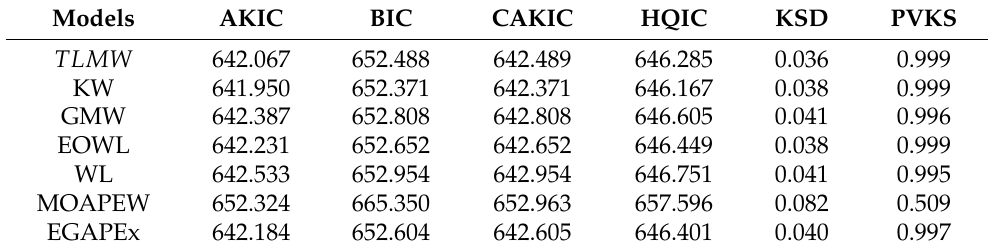
Table 16. Discrimination criteria and KS test of the TLMW model parameters for waiting times. Models